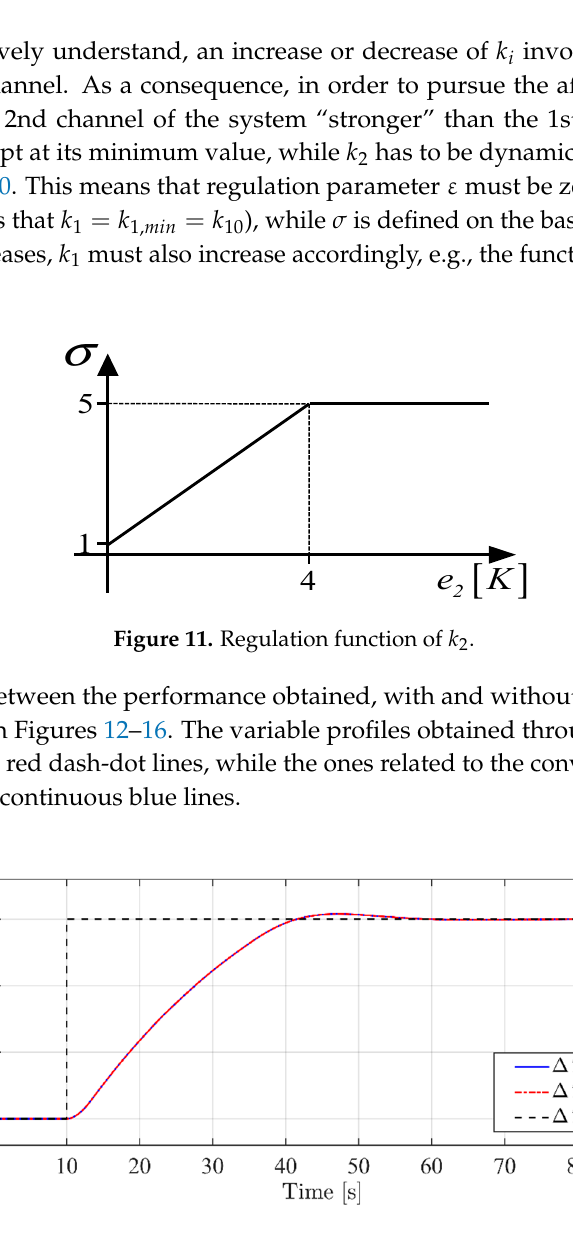
Figure 12. Performance comparison— ∆ T 1 .